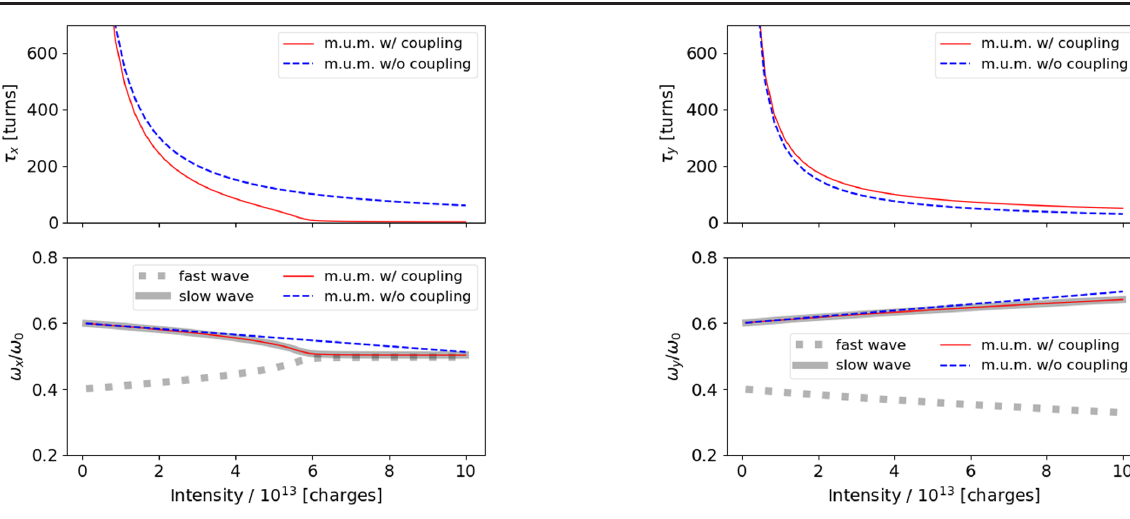
FIG. 5. Same as Fig. 4 for the vertical